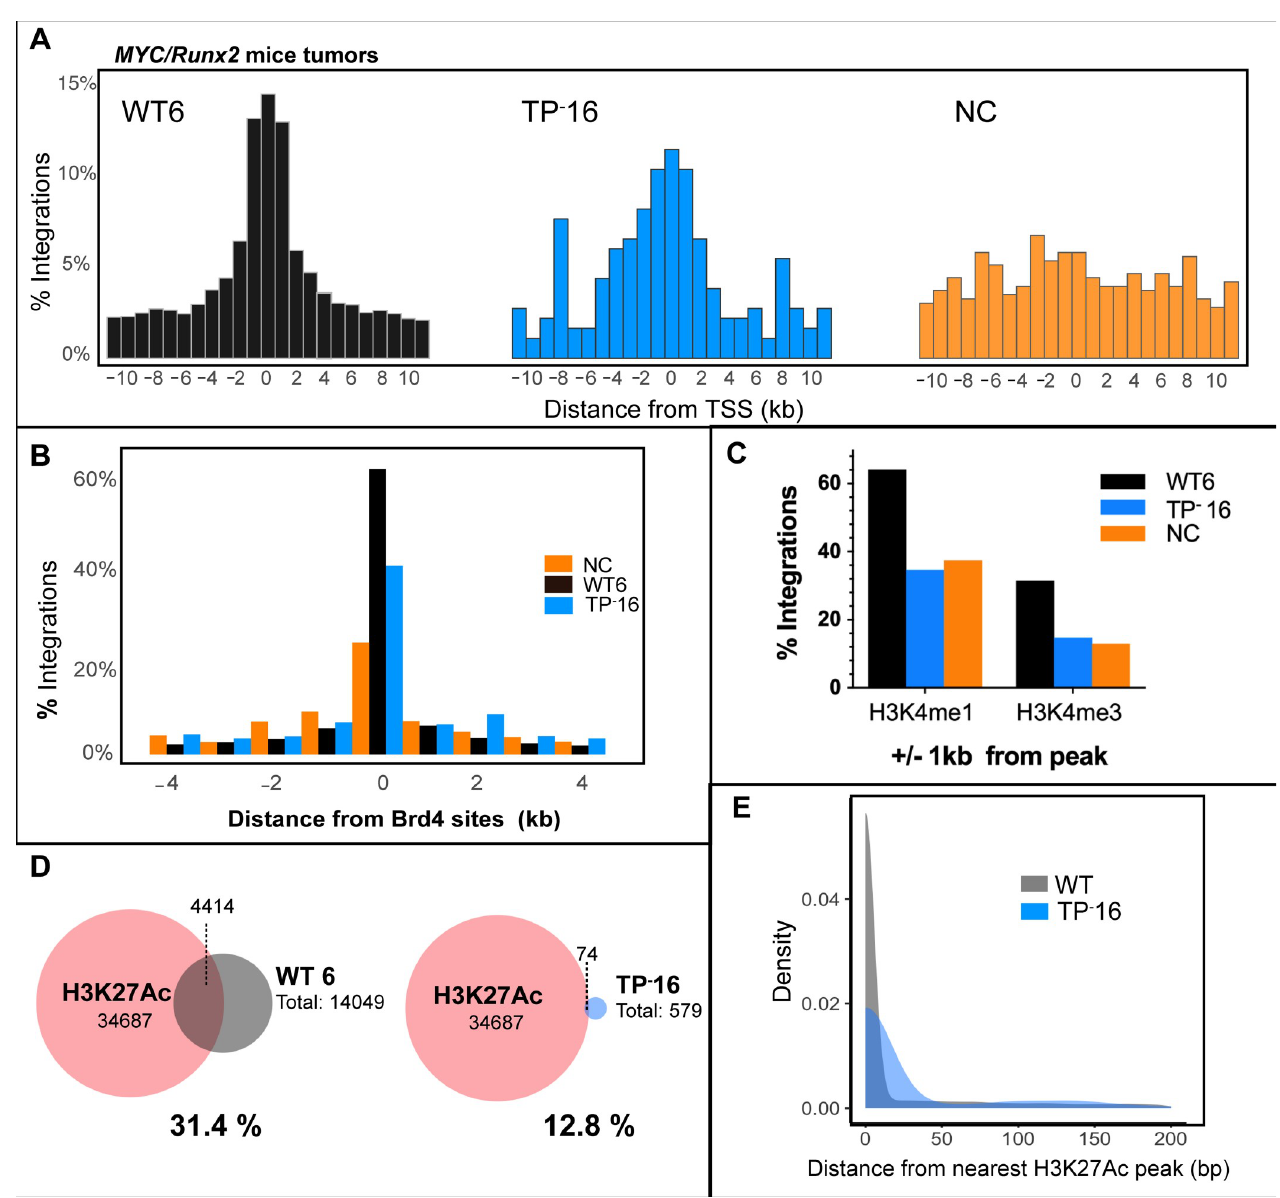
Fig 4. Comparison of MLV integration profiles of tumors from IN TP - 16 and WT6 mice. In all panels, the IN TP - 16 integrants are indicated in blue, WT6 in black/grey, and non-infected control (NC) in orange. (A) Histograms of MLV integration profile with respect to TSSs. (B) Association of RIS with Brd4 binding regions (annotated from GSM1262345). (C) The percentage of RISs that overlap within +/- 1 kB from peaks of histone marks H3K4me1 and H3K4me3. (D) Venn diagram of overlap of H3K27Ac peaks (ENCFF974HMO) with RISs. The dash lines indicate the number of RISs overlapping with H3K27Ac. (E) Density plot of RISs from nearest H3K27Ac peaks. The average WT RISs from all tumor samples (grey) is plotted against TP - 16